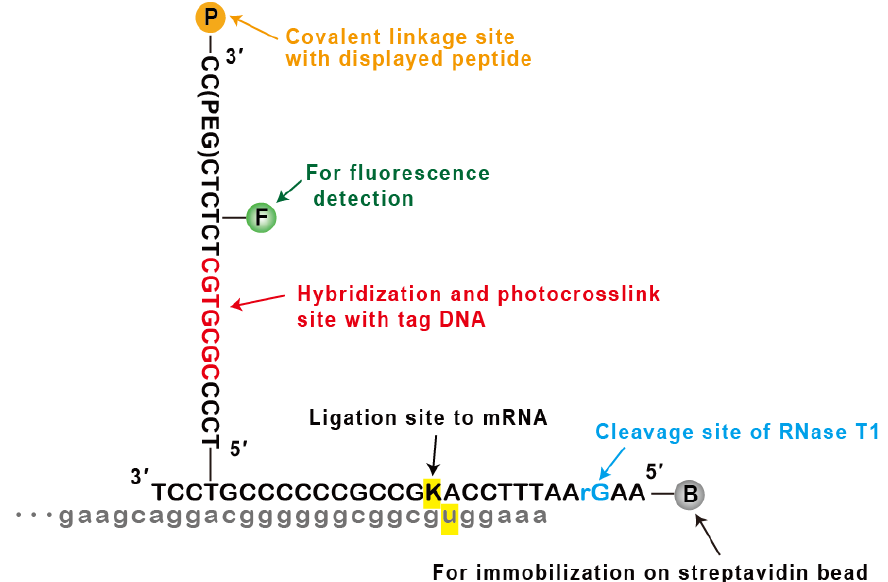
Figure 3. Structure of photocrosslinking (PC)-linker. P indicates puromycin, F indicates fluorescein, B indicates biotin, rG indicates guanine (not deoxyguanine), PEG indicates polyethylene glycol spacer 18, and K indicates cnv K (the ligated bases are highlighted in yellow). For clarity, the 3 ′ terminal of messenger RNA (mRNA) is shown in gray. For more details, please refer to Section 3.